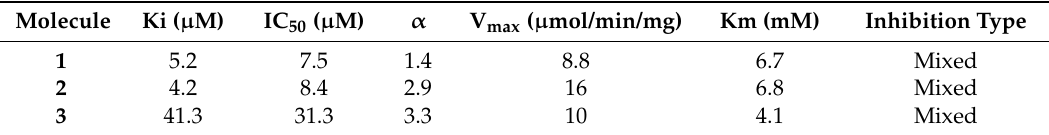
Table 2. Type of inhibition and kinetic parameters for PTP1B inhibitors.